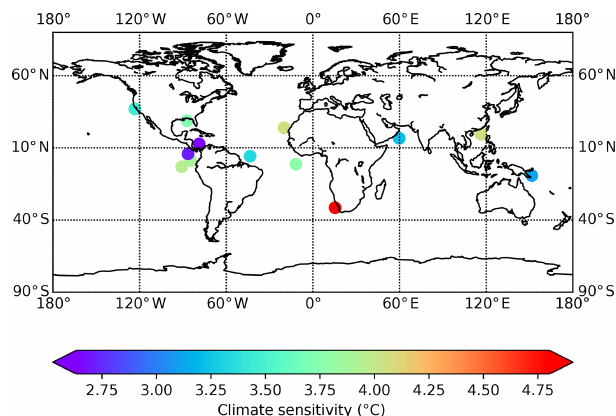
Figure 9. Equilibrium climate sensitivity estimated from the data shown in Fig. 8 based on the modelled grid-point-based regres- sions between Plio Core –PI Ctrl and ECS. This analysis was limited to those data points which were within 1 ◦ C of the range of PlioMIP2 models, and it was also limited to those sites which were in a grid box where the modelling suggested a significant relationship be- tween the Plio Core –PI Ctrl SAT anomaly and the